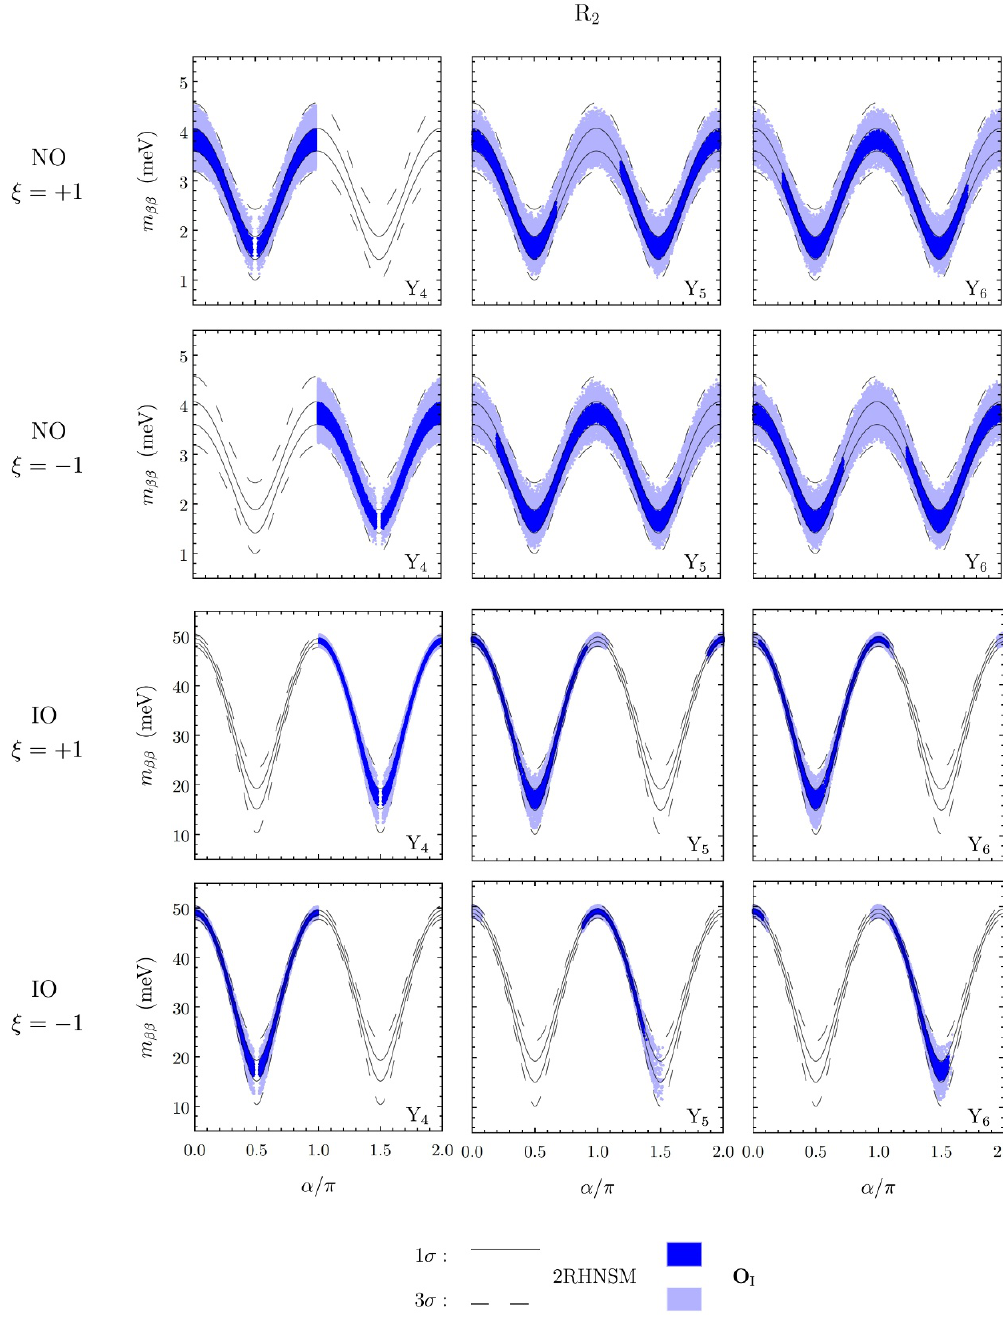
Figure 7 . Allowed regions in the ( (cid:11) , m (cid:12)(cid:12) ) plane for all (R 2 ,Y 4 (cid:0) 6 ) combinations, both for NO (upper plots) and IO (lower plots), (cid:24) = (cid:6) 1, and O of the type O I . The light (dark) blue points were obtained varying (cid:18) ij , (cid:1) m 2 and (cid:14) within the 3 (cid:27) (1 (cid:27) ) experimental ranges given in table 1. The ij solid (dashed) lines are the contours of the 1 (cid:27) (3 (cid:27) ) m (cid:12)(cid:12) regions allowed by the general 2RHNSM previously shown in (cid:12)gure 5. The compatibility regions for O II and O III are the same as those obtained in (cid:12)gure 6.